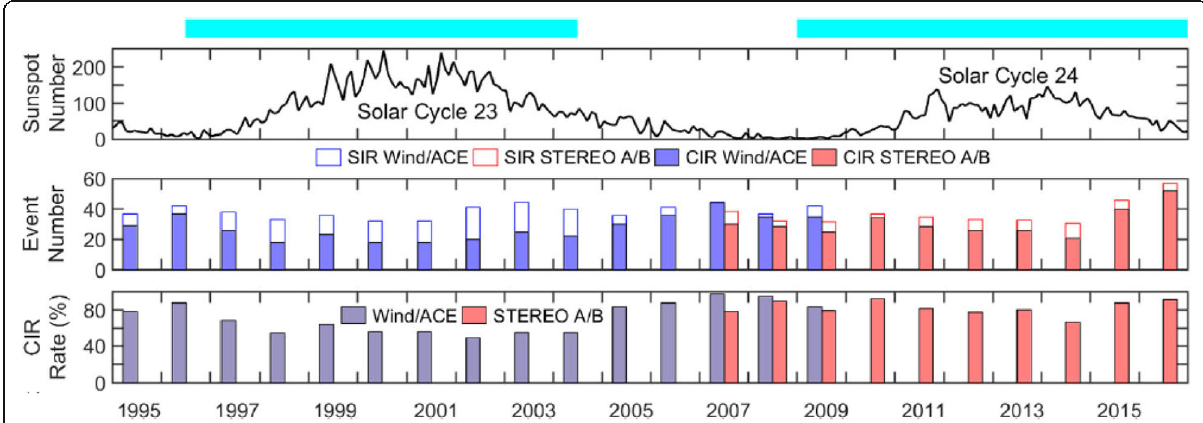
Fig. 8 Monthly sunspot number (top), number of SIR/CIR (middle), and CIR rate (bottom) in solar cycles 23 and 24. Corresponding epochs in cycles 23 and 24 are indicated by the cyan bars at the top (adapted from Jian et al.